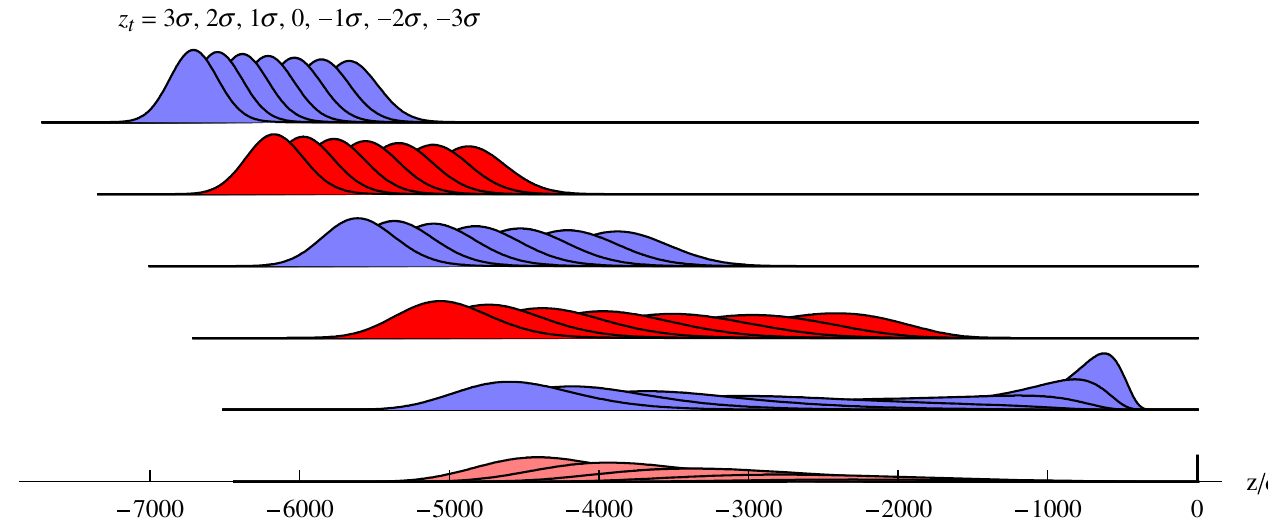
FIG. 9. (Color) The same as Fig. 8, along with image charges at heights nH ¼ n (cid:5) 2 cm (not to scale), which are approximately at heights n (cid:5) 67 (cid:10) , and calculated using Eq.